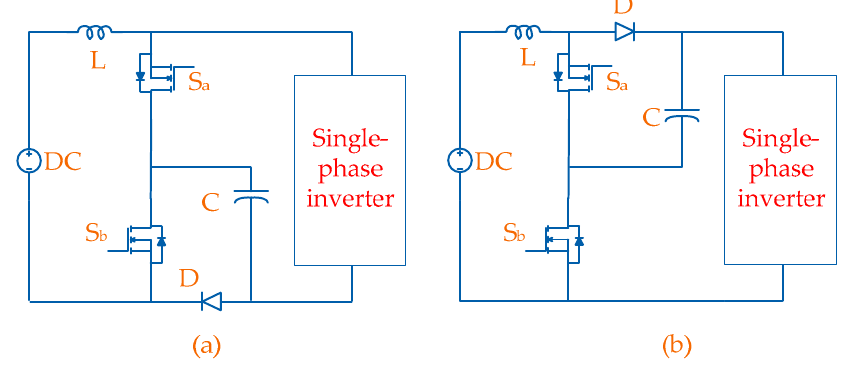
Figure 16. 2-Switch quasi-switched boost inverter ( a )Type 1; ( b )Type 2.